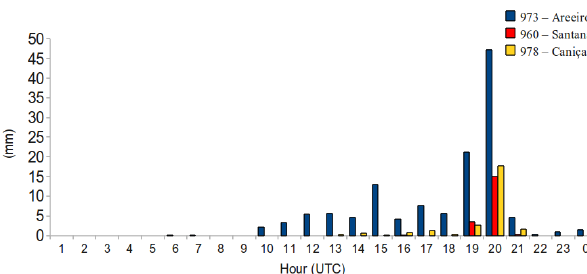
Figure 7. Diurnal variations of total hourly rainfall (mm) for Areeiro, Santana, and Caniçal 2 Fig. 7. Diurnal variations of total hourly rainfall (mm) for Areeiro, station, on 22 December 2009. 3 Santana, and Canic¸al station, on 22 December 2009.